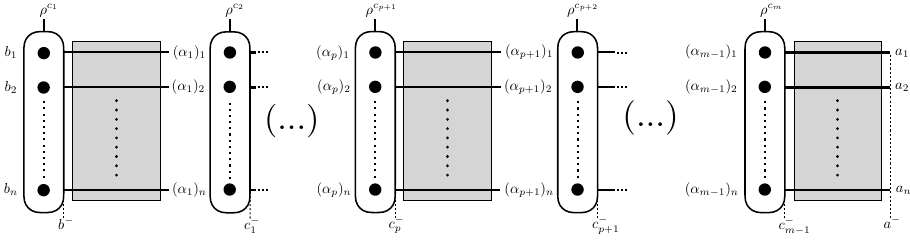
Figure 5 . Schematic representation of the connected correlator H m;n (see eq. (B.5)) for the particular case featured in our calculation. The oblong shapes represent the sum of all possible contractions between an external source and n Wilson lines, whose correlator is represented as a dark square (see (cid:12)gure